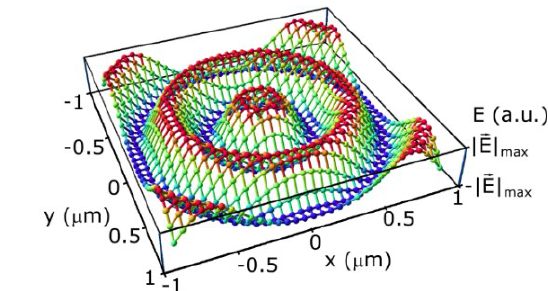
Fig. 1 . O-FDTD electric field spatial distribution illustration. Each oscillator is coupled to its neighbors, allowing electric field wave propagation. (modified from [2]).